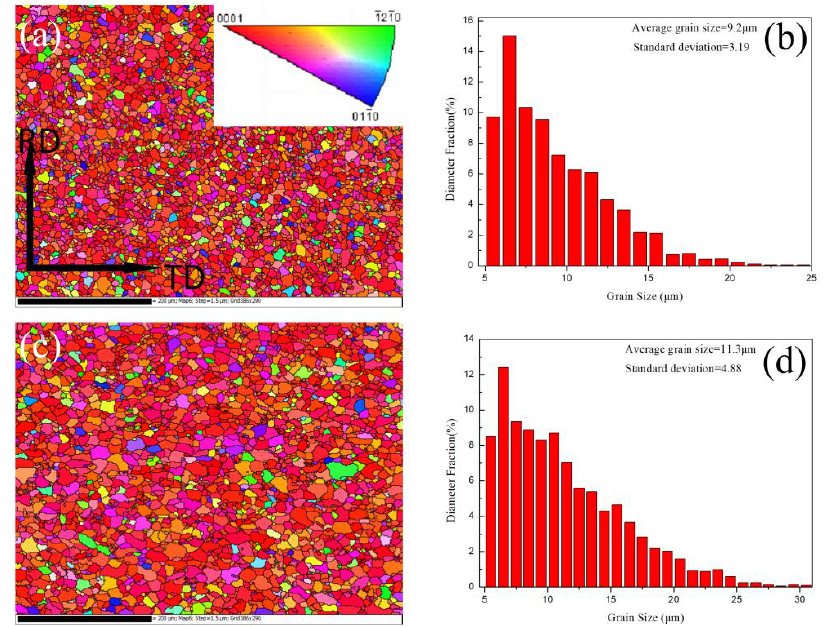
Figure 6. Results of AZ31 alloys HSRBFed to different accumulated strains ( a ) and ( b ) 0.88, ( c ) and ( d ) 1.32, including inverse pole figure maps and grain size distributions.